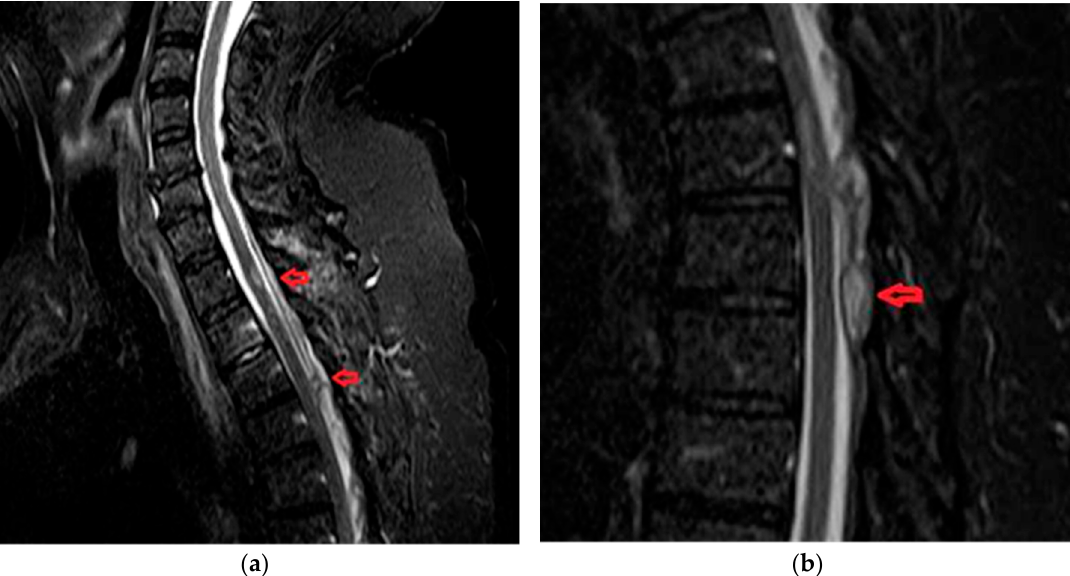
Figure 4. ( a ) MRA shows a “flow voids phenomena” at the dorsal side of the spinal cord below level T2 and multiple zone (T2, T3, T6) with spinal cord edema on T2 ‐ weighted sequence. ( b ) MRA revealed posterior extradural acute hematoma at T2 ‐ T8 spinal levels.